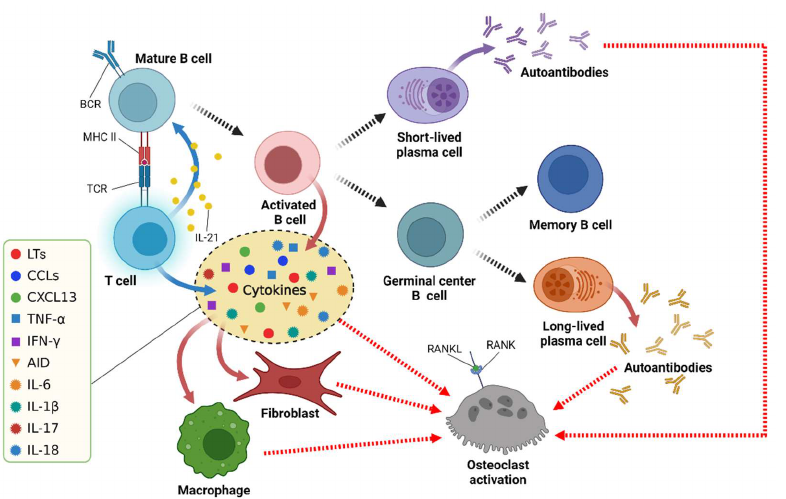
Figure 1. The multiple functions of B cells in RA. BCR = B cell receptor; TCR = T cell receptor; MHC = major histocompatibility complex; RANKL = receptor activator of NF-κB ligand; RANK = receptor activator of NF-κB. Uncited reference: [52]. Created with Biorender.com.